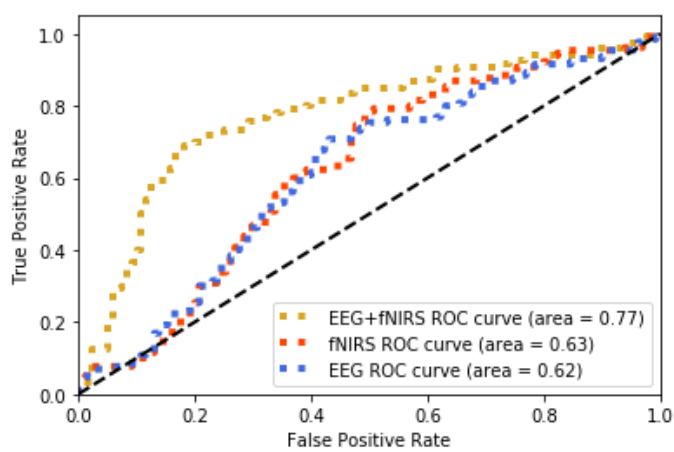
techniques for all video-content trials as displayed. Whiskers are standard deviation.